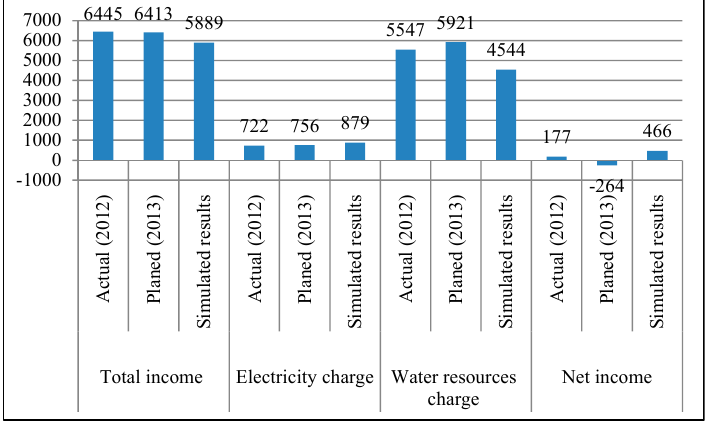
Figure 17. The total income, water resources fee and net income of Tieshi during the period from 3.2 to 3.10 under different situations (unit: 10 4 yuan).